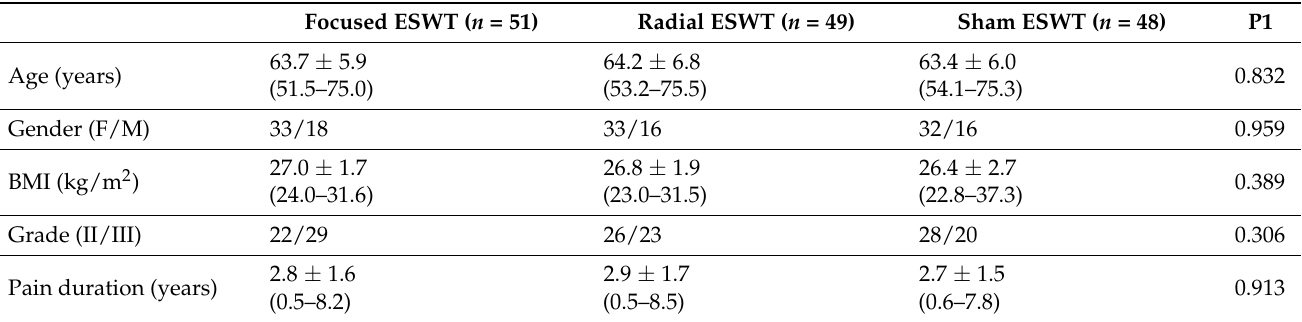
Table 1. Statistical analysis for participants’ characteristics.